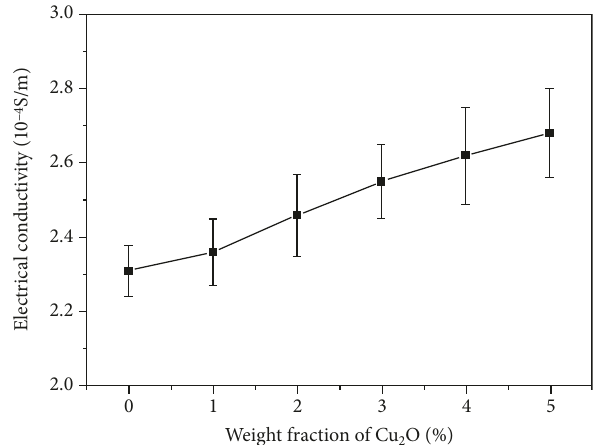
Figure 9: Relationship between the electrical conductivity of ce- ment composites and weight fraction of added nanostructured Cu 2 O particles.